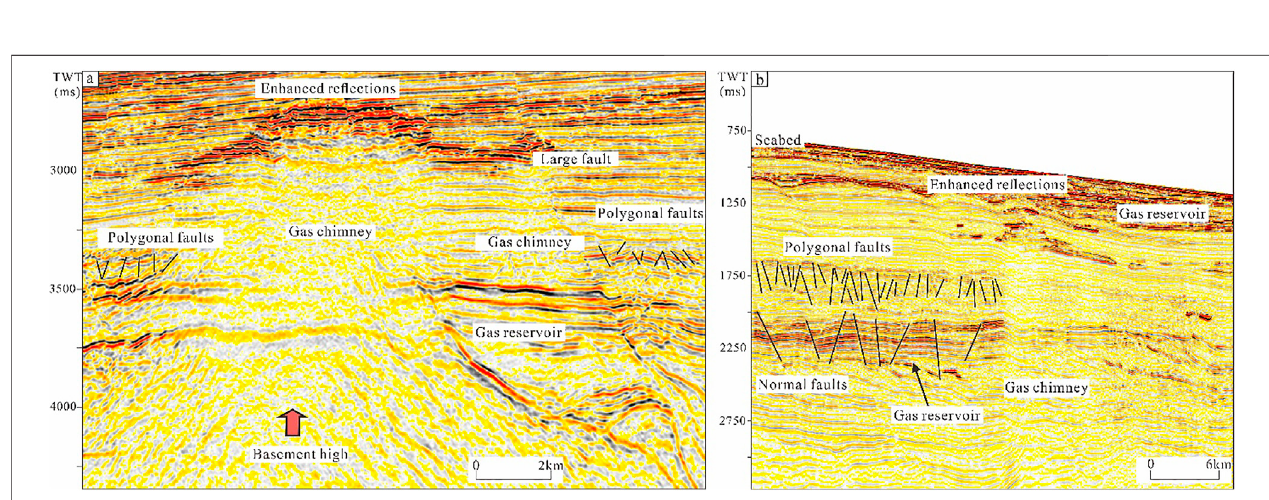
FIGURE7| Seismicpro fi les inthePearlRiverMouthBasin,northernSouthChinaSeashowingthedistribution ofgaschimney,enhancedseismicre fl ections, large normal fault, and PFs. (A) modi fi ed from Sun et al. (2012). (B) modi fi ed from Yang et al. (2017).